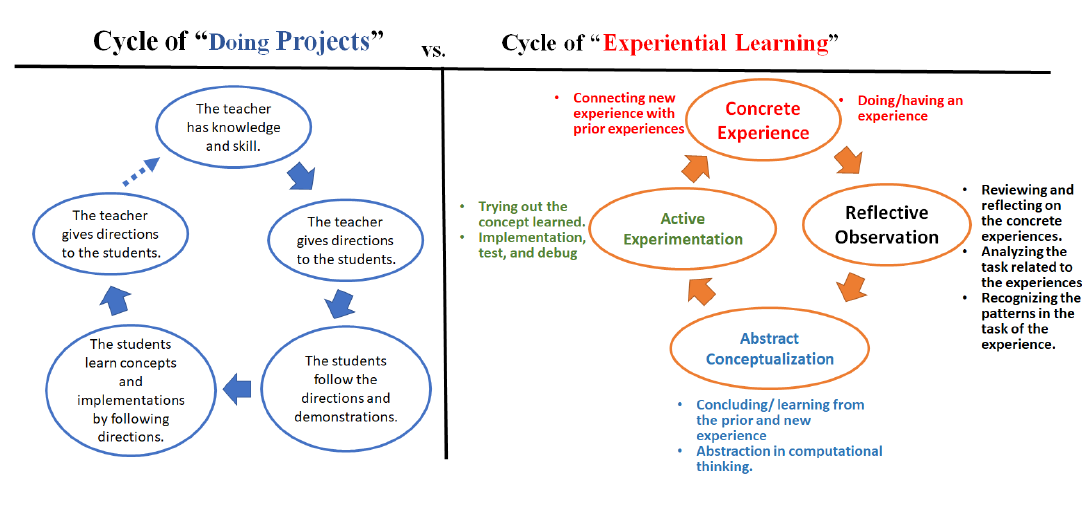
The Cycle of Doing Projects (Control Group) Compared With the Cycle of Experiential Learning (Experimental Group)